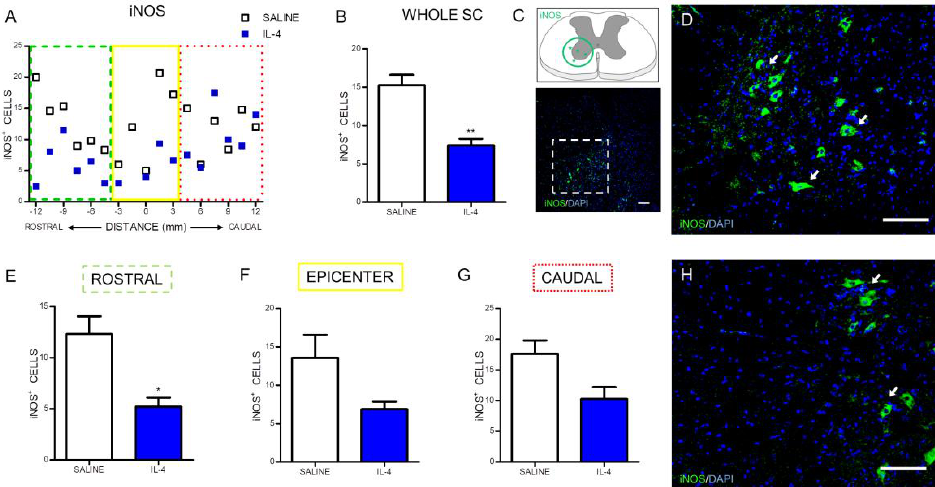
Figure 3. IL-4 treatment reduces the number of iNOS-expressing cells in the injured spinal cord. Distribution of iNOS + cells along the rostrocaudal axis of the spinal cord ( A ); Quantification of iNOS + cells in the whole spinal cord revealed a significant reduction of iNOS-producing cells in IL-4-treated rats ( B ); A significant reduction of iNOS-expressing cells was also observed in the rostral ( E ) area of the spinal cord but not at the epicenter ( F ) and in the caudal ( H ) regions. Schematic and low-magnification photomicrograph indicating areas where the analyses were performed (dashed lines) ( C ); Representative images of positive staining for iNOS + cells of saline ( D ) and IL-4 treated ( H ) group. Values shown as mean ± SEM. * p < 0.05; ** p <0.01. Scale bar = 100 µ